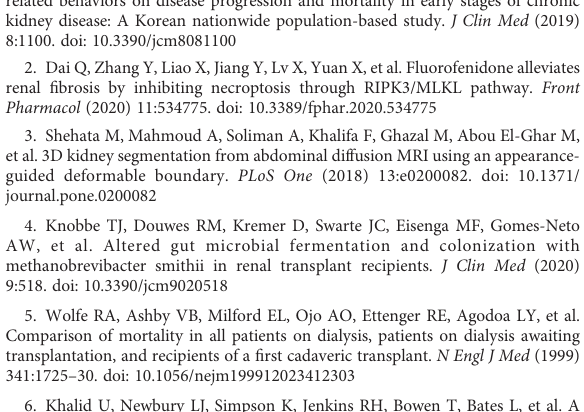
SUPPLEMENTARY TABLE 1 Primers of 15 genes for RT-qPCR. SUPPLEMENTARY FIGURE 1 The fl owchart of patient screening and recruitment in our